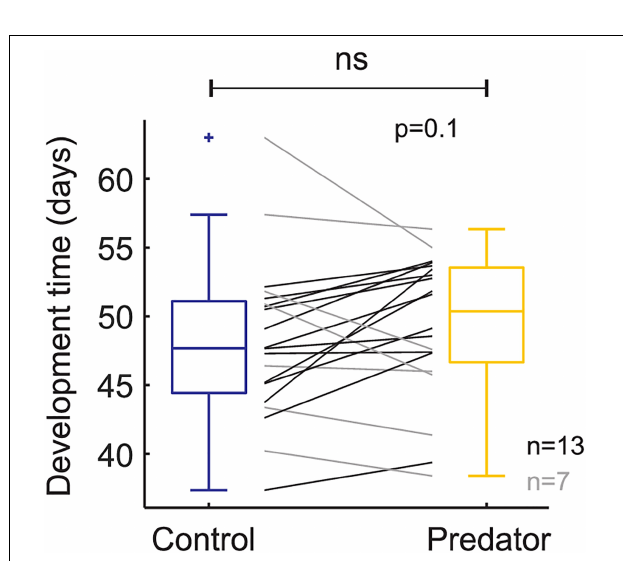
FIGURE 5 | Larval development time based on raw data (i.e., each black and gray line represents a family). Boxplots show the mean values on control and predator treatment. + means outlier.